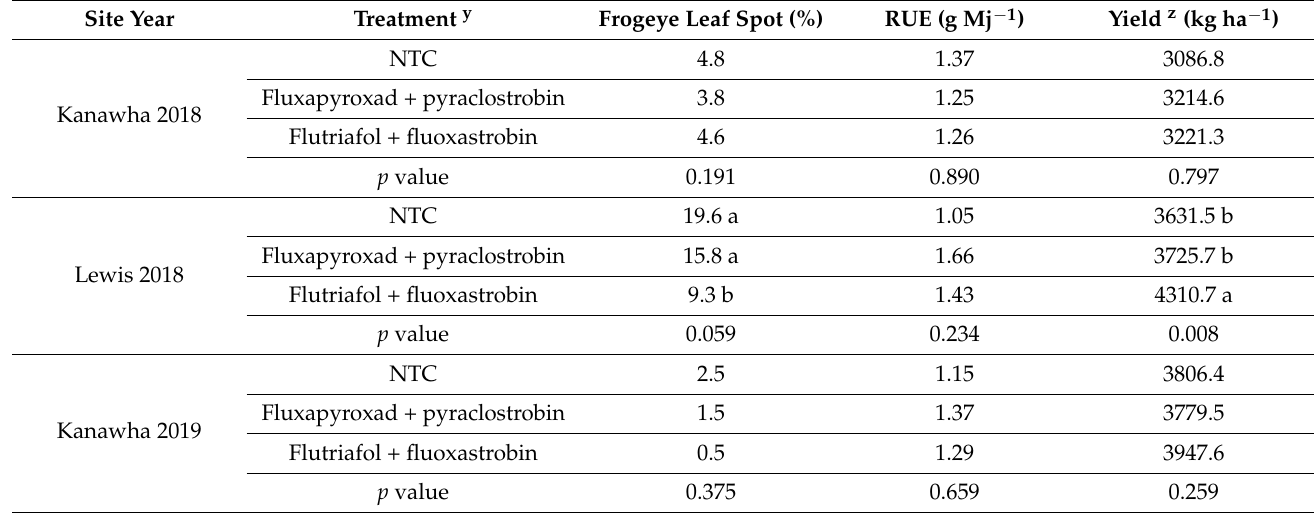
Table 4. Least square means x of yield, frogeye leaf spot severity, and radiation use efficiency (RUE) for different fungicide treatments in three locations in Iowa during 2018 and